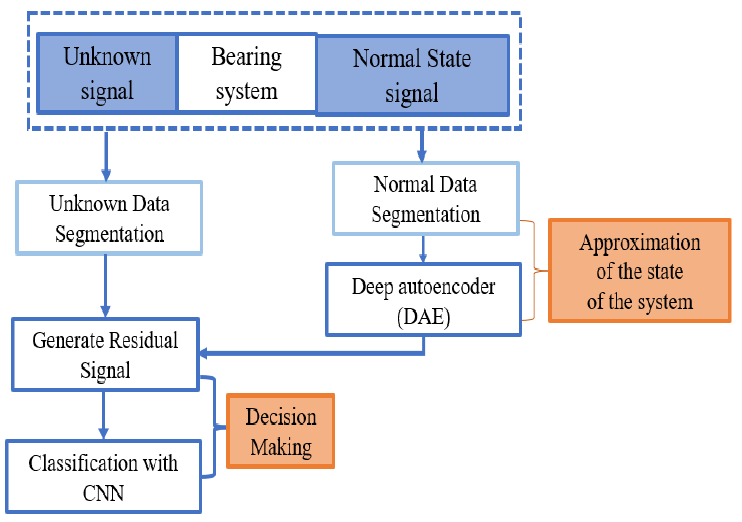
Figure 2. The designed framework of a DAE-CNN-based fault classification